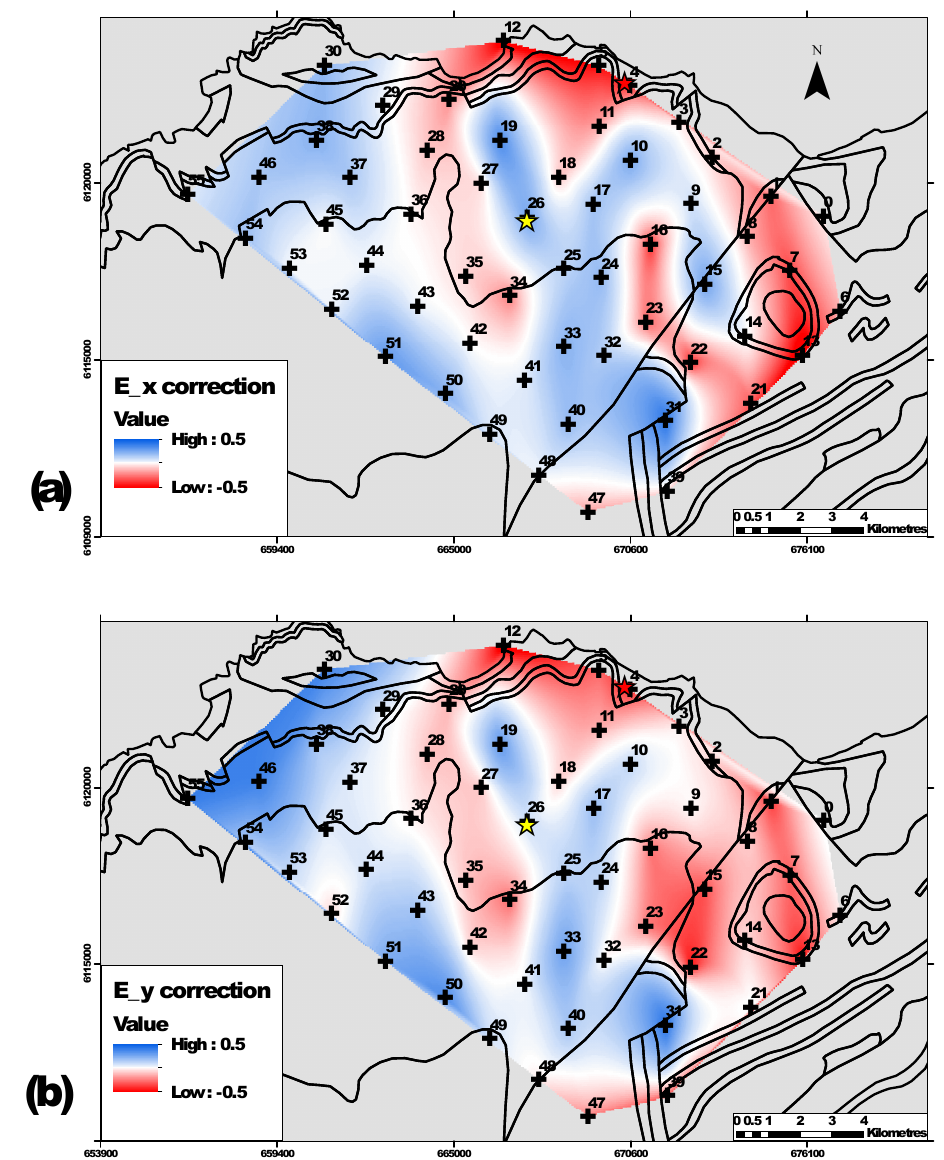
Figure 7. Spatial distribution of static correction factors δ E (a) and δ E (b) in decades (i.e. as additive factors, where + 0.5 corresponds to x y a multiplicative factor of 10 0 . 5 , ≈ 3). Blue shading indicates resistive corrections to the data, whereas red indicates conductive corrections. Note that for the majority of sites, δ E and δ E are similar in magnitude and polarity. The magnitudes of static corrections are generally less x y than 0.5 decades in size, corresponding to apparent resistivity estimates being shifted by factors of less than